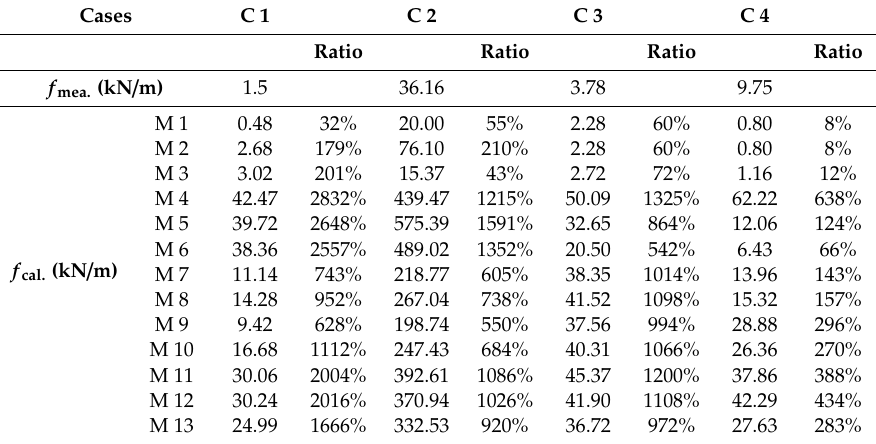
Table 5. Comparison of friction resistances calculated by the existing models and the measured